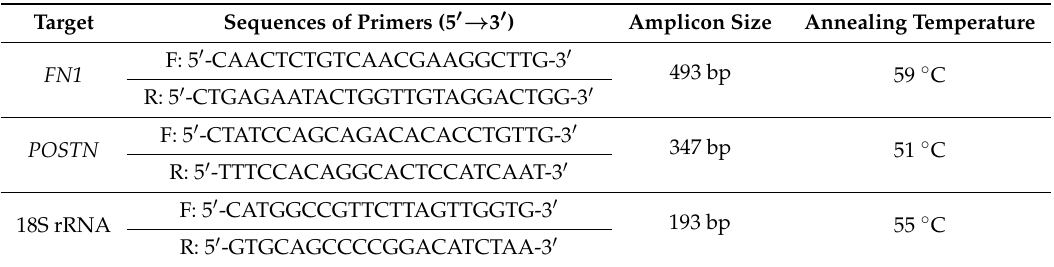
Table 5. Primer sequences and conditions used for semi-quantitative PCR analysis of FN1 and POSTN expression; F—forward primer, R—reverse